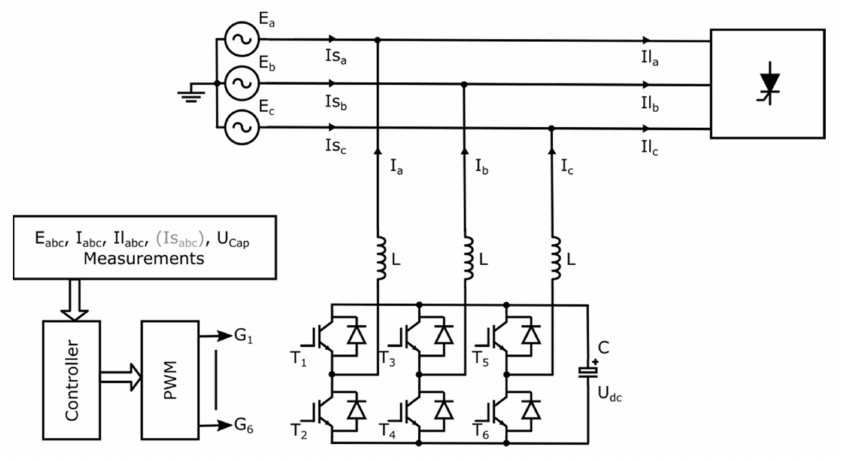
Figure 1. Functional diagram of the